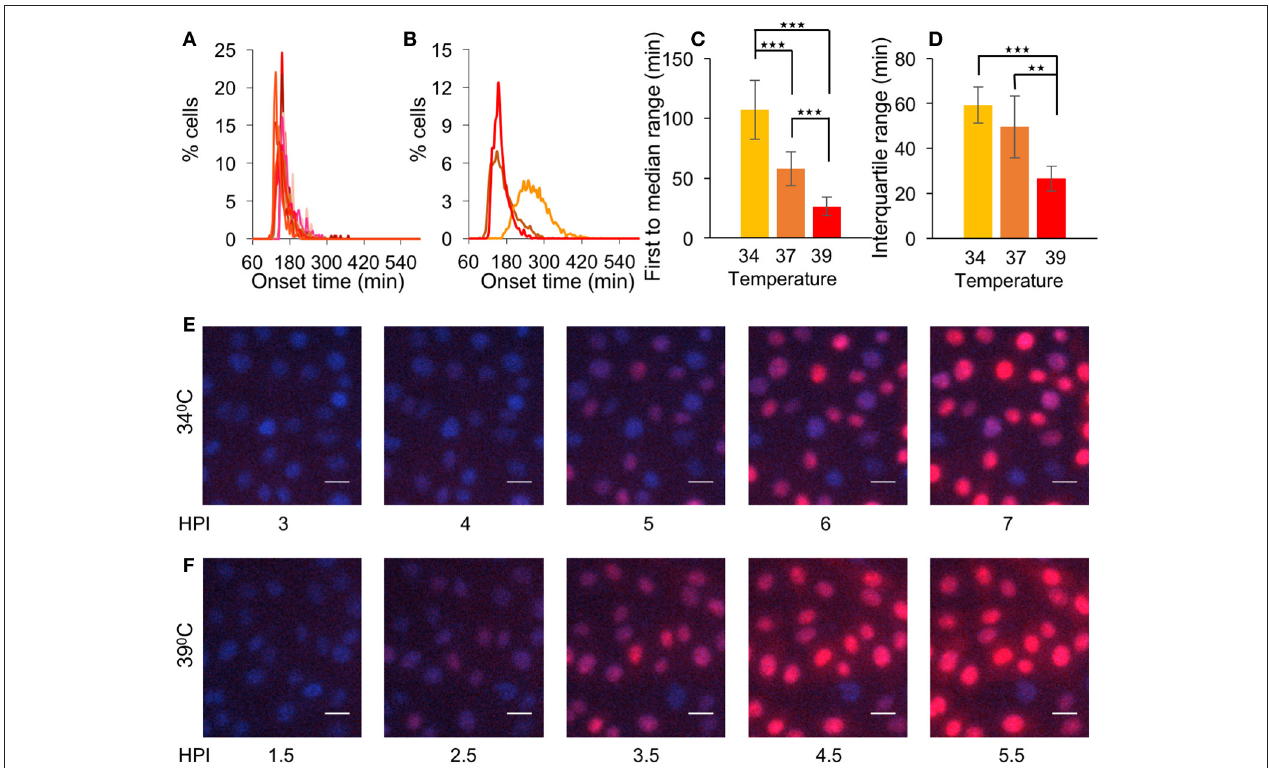
FIGURE 4 | Elevated temperature increases simultaneous gene expression. (A) Cells were infected with OK11 recombinant virus at 39 ◦ C, at MOI 20. Histograms present the percentage of cells at each time point, that initiated expression (binning every 5min). Fourteen wells from four experiments done on different days were plotted (at least two wells per experiment). (B–D) A comparison between the onset times of expression for the infection at different temperatures: 34 ◦ C (yellow, data from Figure 3B ), 37 ◦ C (orange, data from Figure 2D ) and 39 ◦ C (red, data from (A) . (B) The average histograms for each condition were plotted. (C) The time between the first cell onset of expression to the median cell onset (first to median range) was plotted for each condition. (D) The interquartile range was plotted for each condition. (B–D) Error bars represent the standard deviation among the different wells. ** P < 0.01, *** P < 0.001 by student T -test. (E–F) Cells were infected with OK11 recombinant virus at MOI 20 and incubated at either 34 ◦ C (E) or 39 ◦ C (F) . Snapshots at different time points (as indicated) are presented. Nuclei are colored with Hoechst stain in blue, mCherry fluorescence in red. Scale bar 20 µ